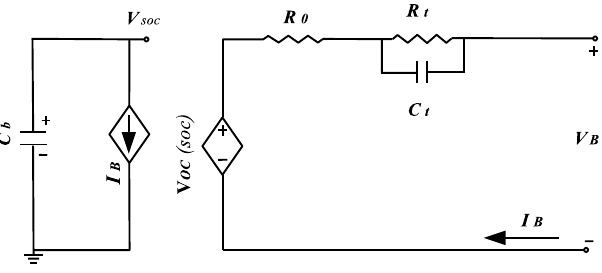
Figure 1. Equivalent circuit model of the